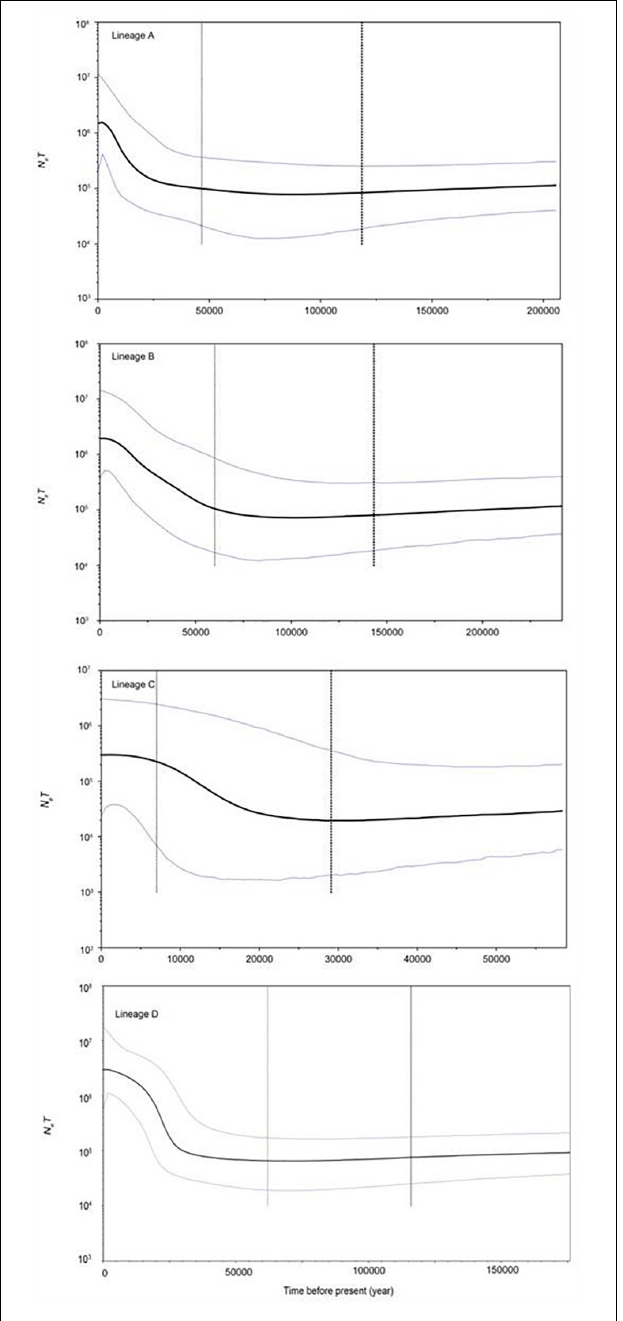
FIGURE 7 | BSP results revealing changes of N e T ( N e = effective population size; T = generation time) through time inferred by BEAST software based on mtDNA D-loop data set. Blue lines represent the upper and lower 95% highest posterior density (HPD) limits of NeT; and the vertical dotted line represents the median estimate of time to most recent common ancestor (TMRCA). The y -axis is plotted on a logarithmic scale.